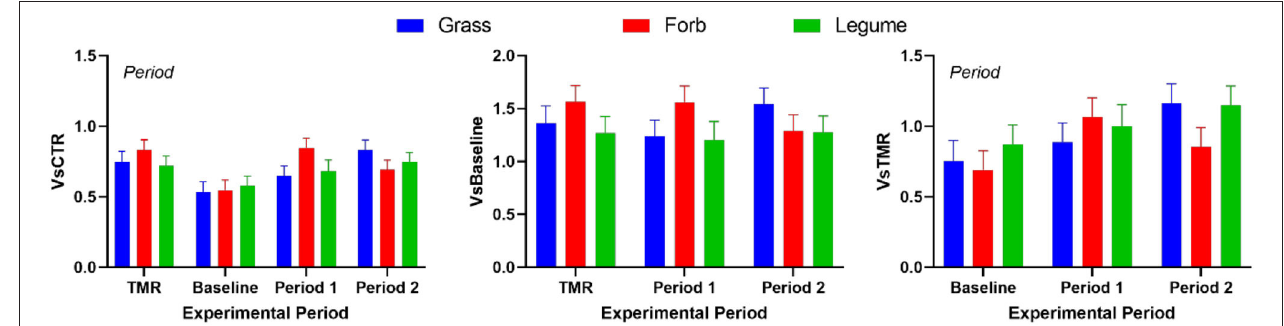
FIGURE 1 | Nuclear factor erythroid 2-related factor 2 (NRF2) modulation measured by luciferase luminescence in mammary alveolar cells (MACT) by serum collected in the cows while fed total mixed ration (TMR), permanent pasture during the baseline, and when grazing ryegrass and white clover pasture (Grass), pastures rich in chicory and plantain (Forb), or Legume-rich pastures (Legume) (i.e., Experimental) during April 29 to May 19 (Period 1) and May 19 to June 6 (Period 2) of 2019. The cells were also treated with 10 µ M sulforaphane (SFN) in Dulbecco’s modified Eagle’s medium (DMEM) as positive control and only DMEM as a negative control. The negative control was used to correct for variation between the plates. The data are a ratio of ARE-luciferase/TK-Renilla luciferase in each sample relative to the negative control (CTR). Except for SFN and DMEM where a minimum of three technical replicates was used, there were n = 3 biological replicates per treatment as a pool of serum from the three cows in the same grazing plot ( n = 3 plots per group). Data are shown and were statistically analyzed as a ratio of luciferase/renilla relative to CTR (VsCTR) for all the groups while receiving TMR in Baseline pasture or during the two periods of the Experimental pastures; as fold relative to Baseline (VsBaseline); or as fold relative to TMR (VsTMR). The statistical effect of Period is indicated in the graph when present. The treatment of MACT cells with SFN in DMEM activated NRF2 10.93 ± 1.25 fold relative to DMEM